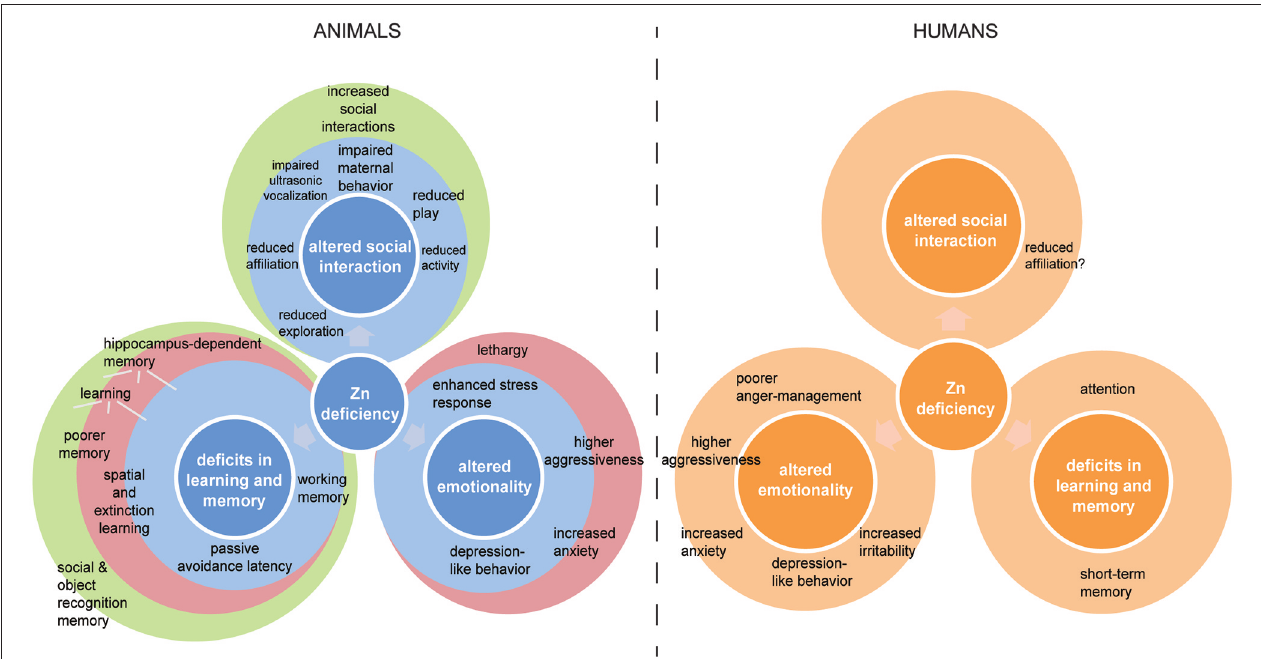
particular animal model and within circles if they occurred in more than one group. Some of the behavioral alterations in animal models can be found mirrored in the behavior of human (right) zinc deficient individuals. Only impairments with strong validation are shown. Although possibly more similarities between zinc deficient humans and animals exist, more research on human zinc deficiency is necessary to exclude confounding